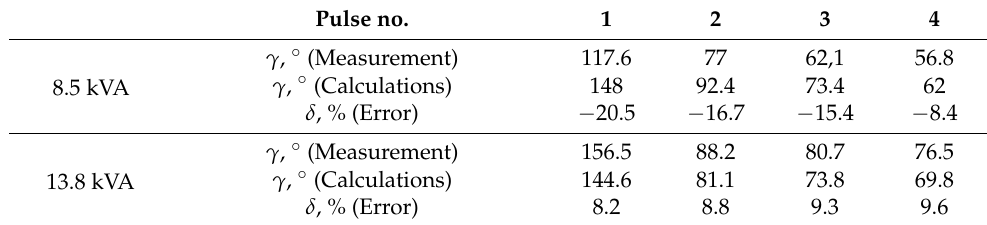
Table 5. Comparison of the duration of inrush current pulses.